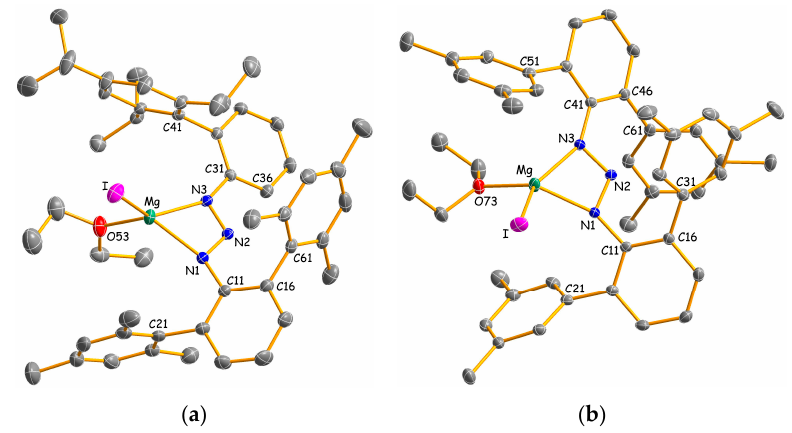
Figure 1. Molecular structures of 2a ( a ) and 2b ( b ) with thermal ellipsoids set to 30% probability. Hydrogen atoms have been omitted for clarity. Selected bond lengths (Å), angles and dihedral